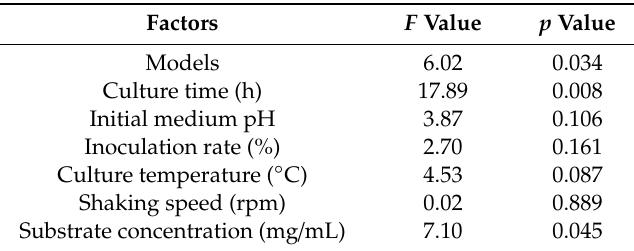
Table 3. Variance analysis of Plackett–Burman (PB)